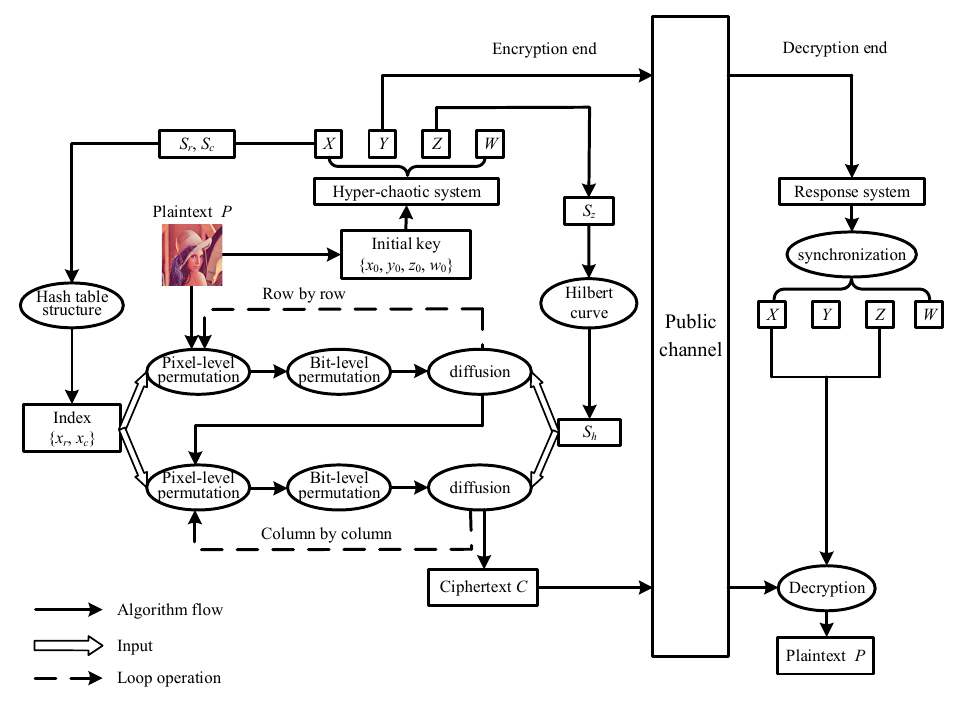
Figure 8. Flowchart of algorithm.